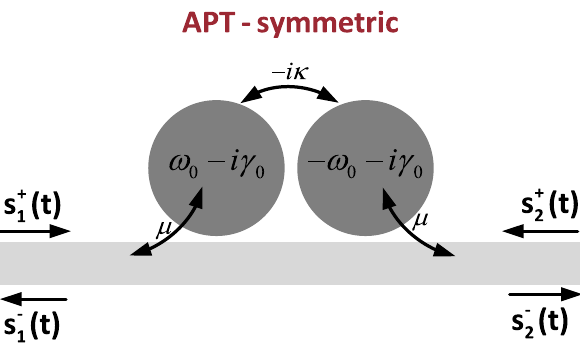
Figure 7: Power reflection and transmission spectra for ω 0 = 1 , γ 0 = 0 . 05 , γ (a) Fano resonance with κ < κ EP . (b) Fano resonance with κ = κ EP . (c) Fano resonance plus Lorentzian resonance with κ > κ EP .